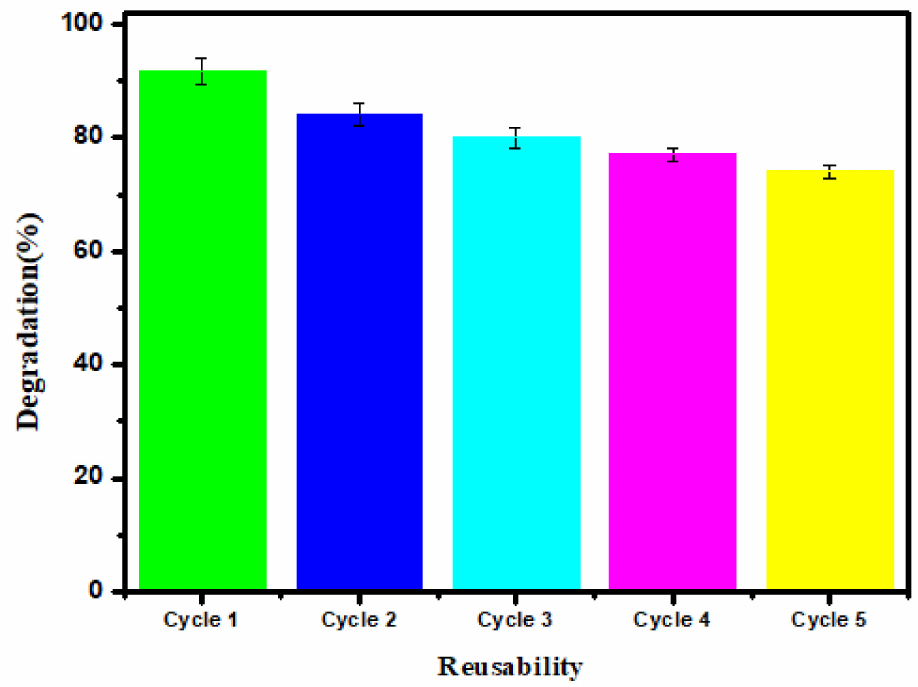
Figure 8. Stability analysis of TNG-08 under optimized